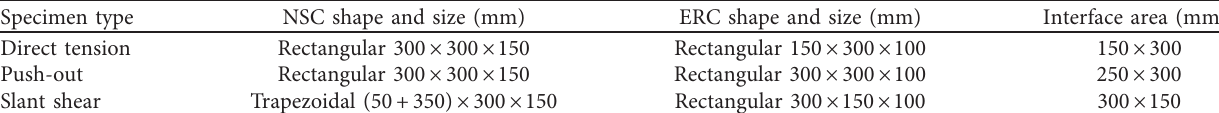
Table 3: Details of three kinds of specimens.